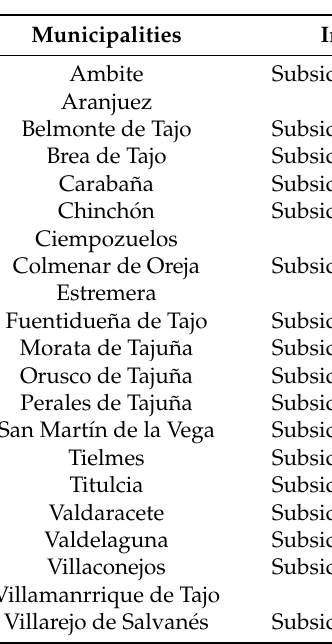
Table 3. Planning State, instrument type, and approval